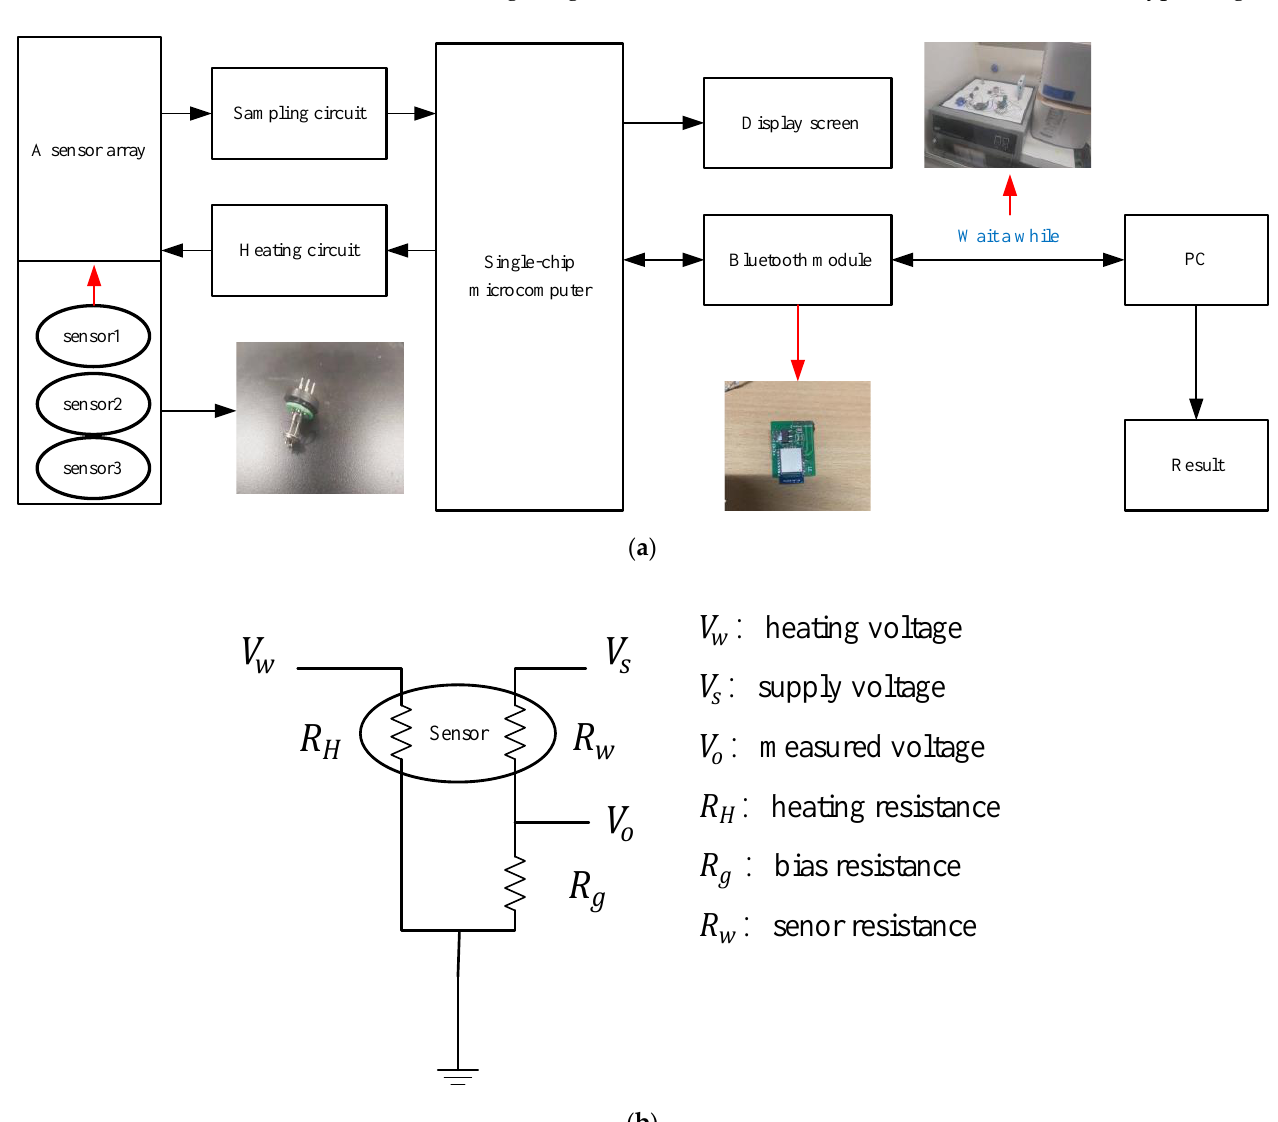
Figure 2. A schematic diagram of the experiment and measurement circuit. ( a ) Schematic diagram of the experiment; ( b ) measurement circuit.